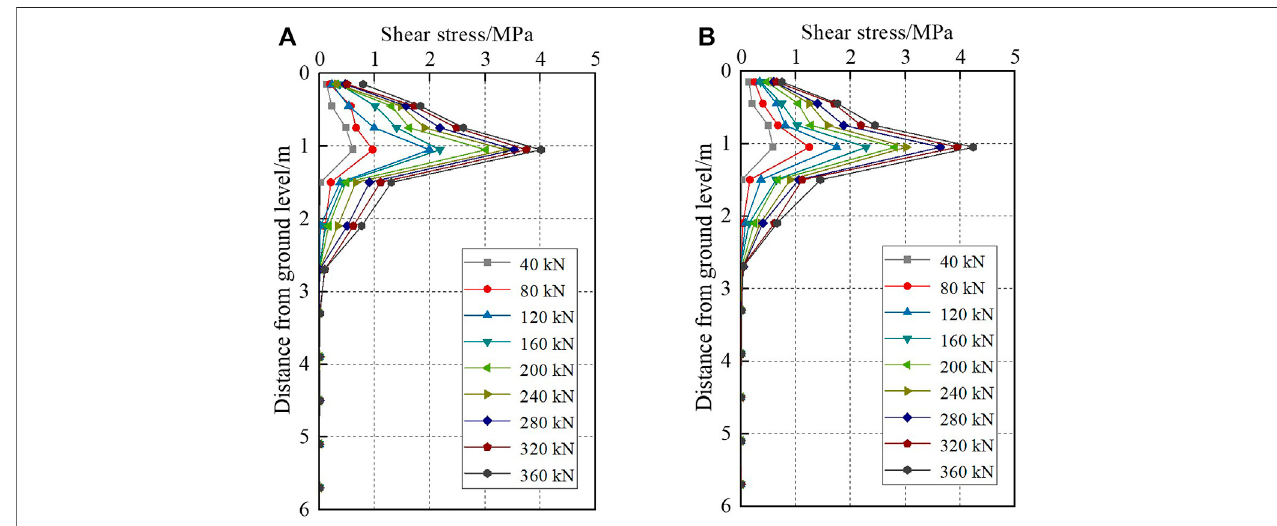
FIGURE 7 | Relationships between the average shear stress and depth: (A) GFRP1 and (B) GFRP2.